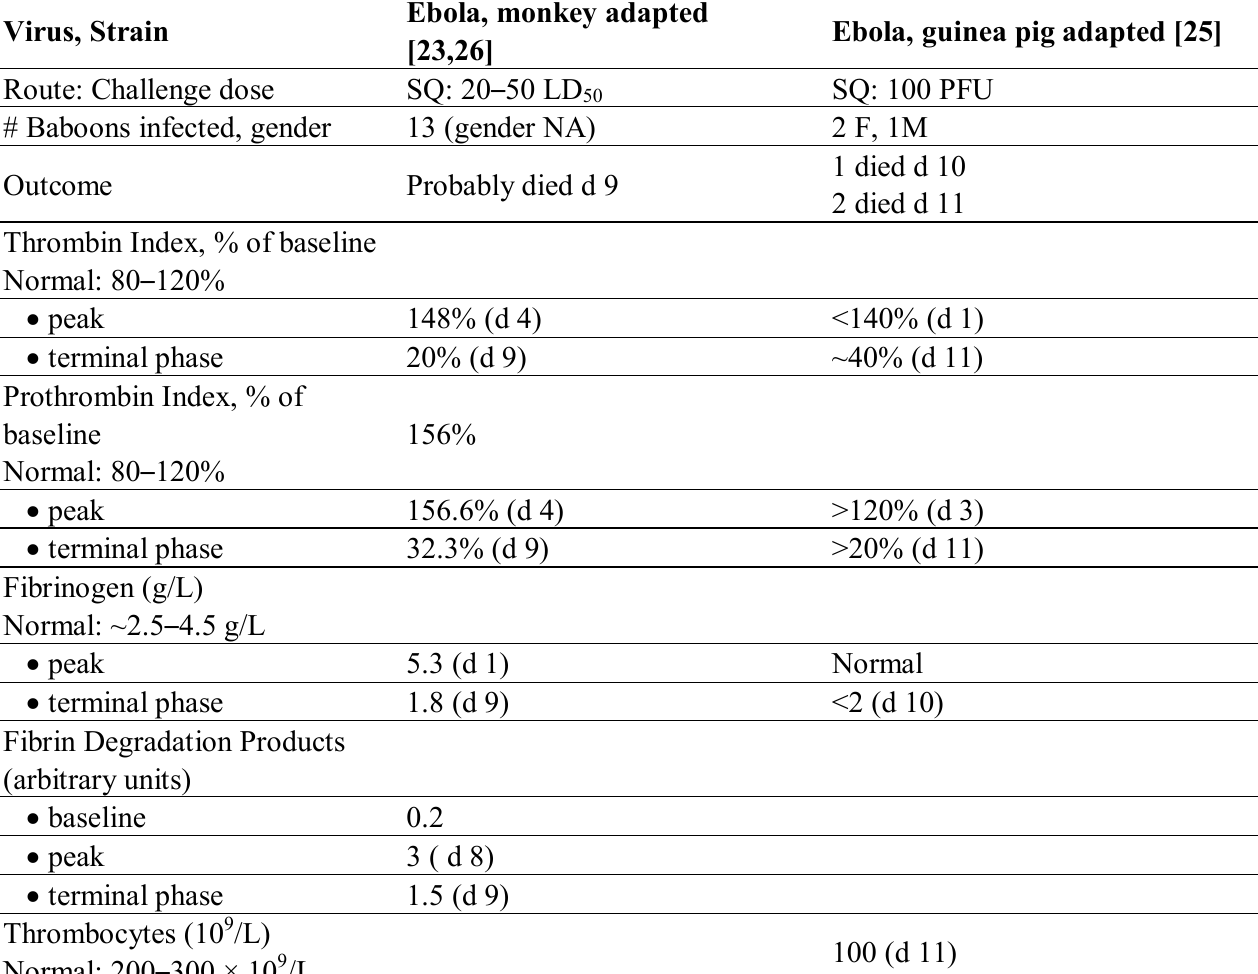
Table 2 . Coagulation Parameters in Baboons Infected with Ebola